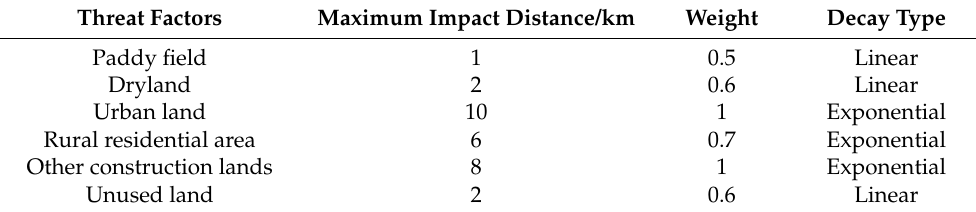
Table 1. Weight assignment and maximum influence of threat